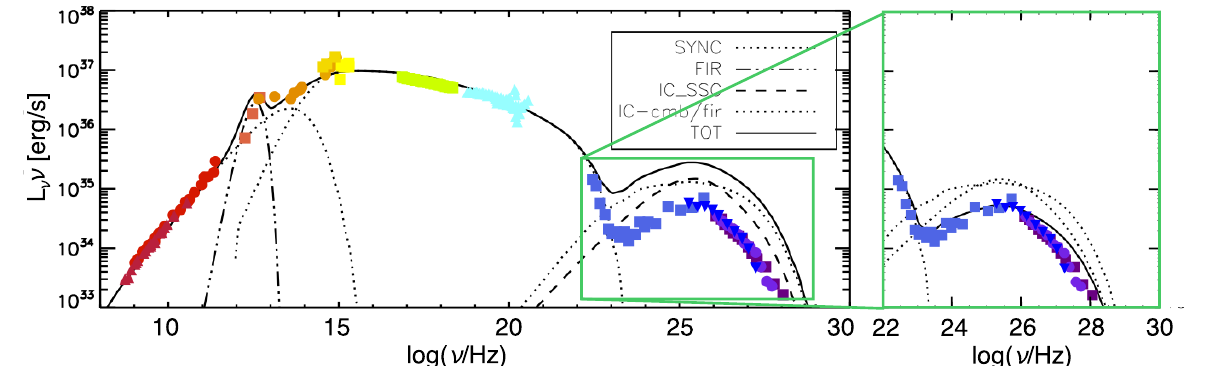
Figure 5. Total integrated spectrum of the Crab nebula computed on top of the 2D MHD numerical model by [77]. The zoom-in on the gamma-ray spectrum highlights the fact that the IC emission can be correctly reproduced if the magnetic field strength is artificially rescaled so as to ensure an average value of ∼ 200 µ G (this is how the spectrum in the inset is obtained). Different symbols-colors reproduce data at the different energy bands, as taken from [83] and references